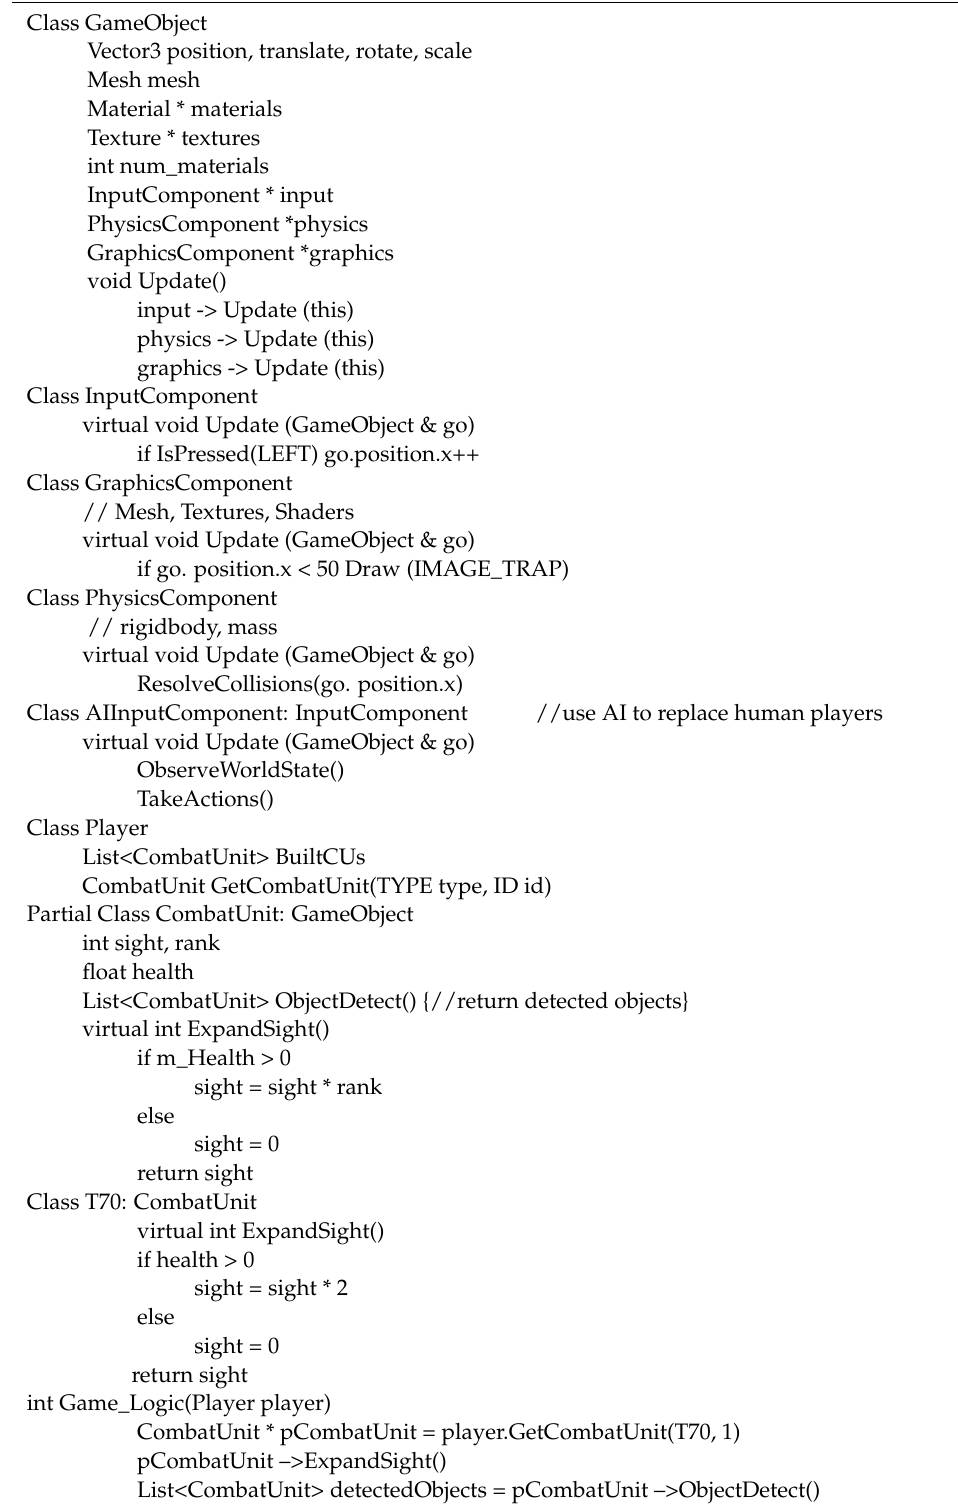
Algorithm 3: GameObject with